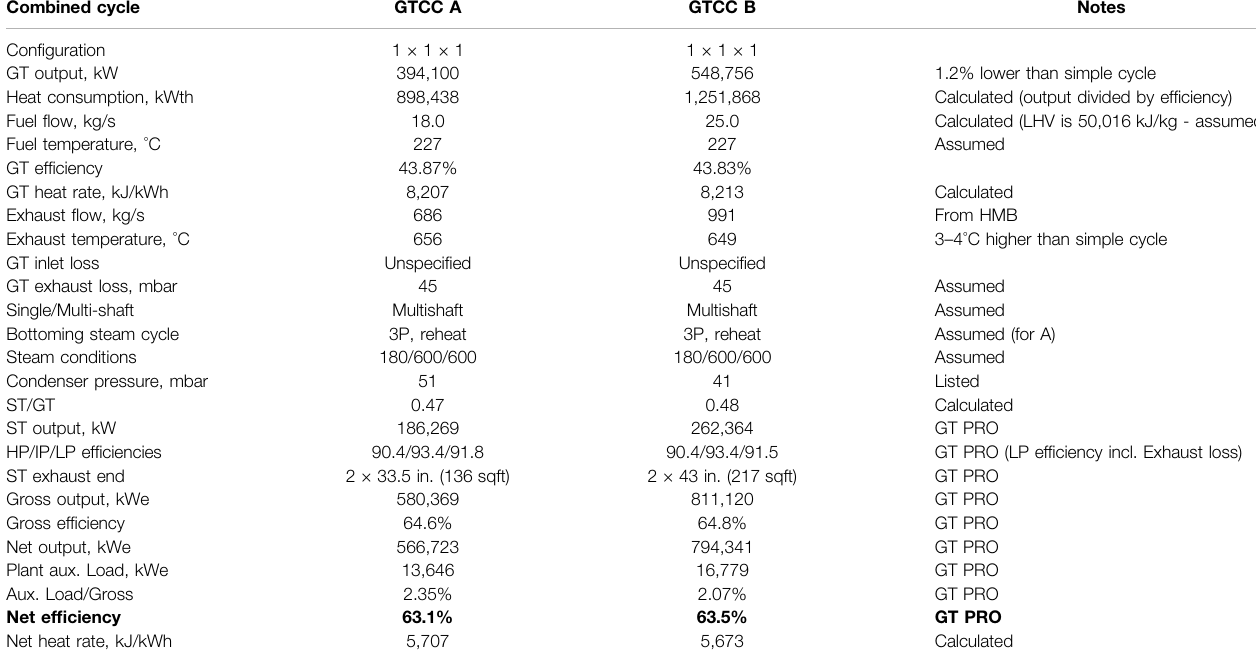
TABLE 8 | Combined cycle performance estimates with advanced class gas turbines. Combined